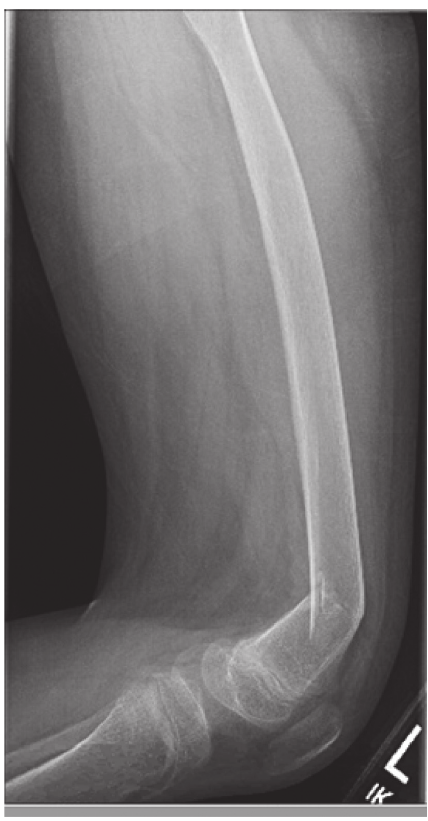
Figure 1: Left femur